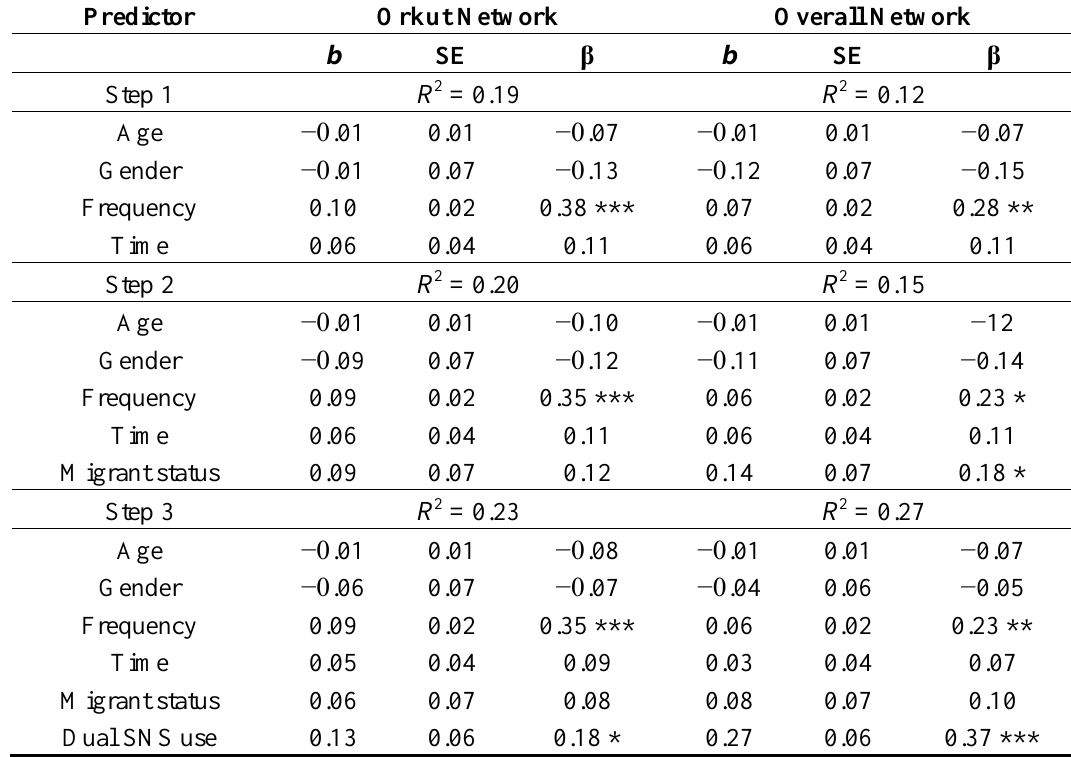
Table 8. Summary of regression results for predicting online network characteristics from migrant status and dual SNS use, controlling for age, gender, frequency of Orkut use and duration of Orkut